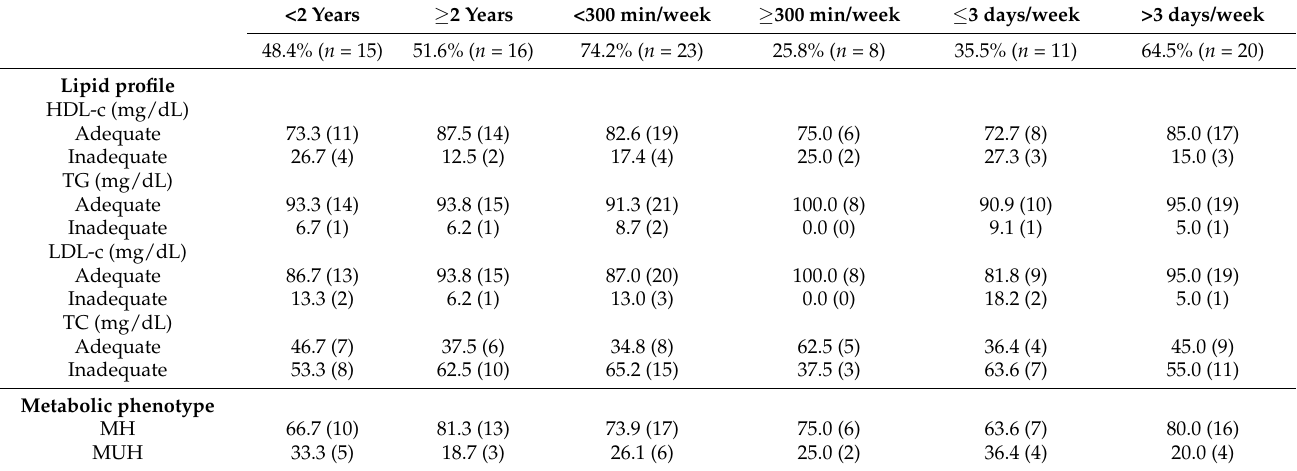
Table 3. Association between lipid profile and metabolic phenotypes according to time in years, in minutes per week and weekly frequency of RT.